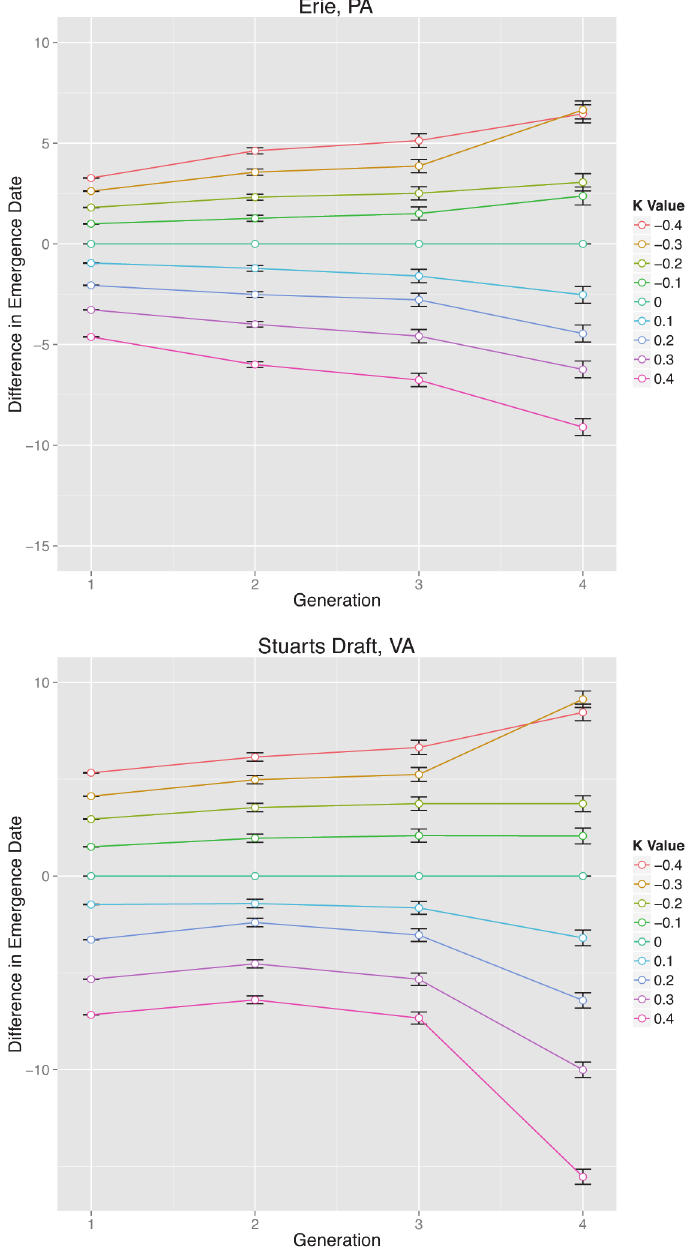
Fig 2. Change in P . viteana Mean Emergence Date for Four Generations under Same Mean with Various DTR Change Conditions. Note: Upper panels: Erie, PA; lower panels: Stuarts Draft, VA. Different colors indicate different k values (see figure legends). The error bars indicate standard errors. Positive numbers in y-axis indicate later emergence date (differences in emergence dates comparing to current k = 0 condition) while negative numbers indicate earlier emregence date. The difference among all DTR conditions are more obvious at the 4 th generation than earlier